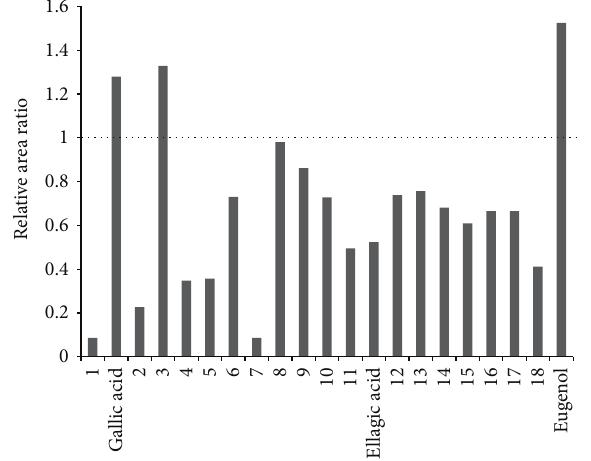
Figure 4: Relative area ratio of the 18 selected peaks in the chro- matogram of Syzygium aromaticum (SA) and Syzygium aromaticum combined with Curcuma aromatica (SAC). The ratios mean relative peak areas of SAC divided by those of SA.